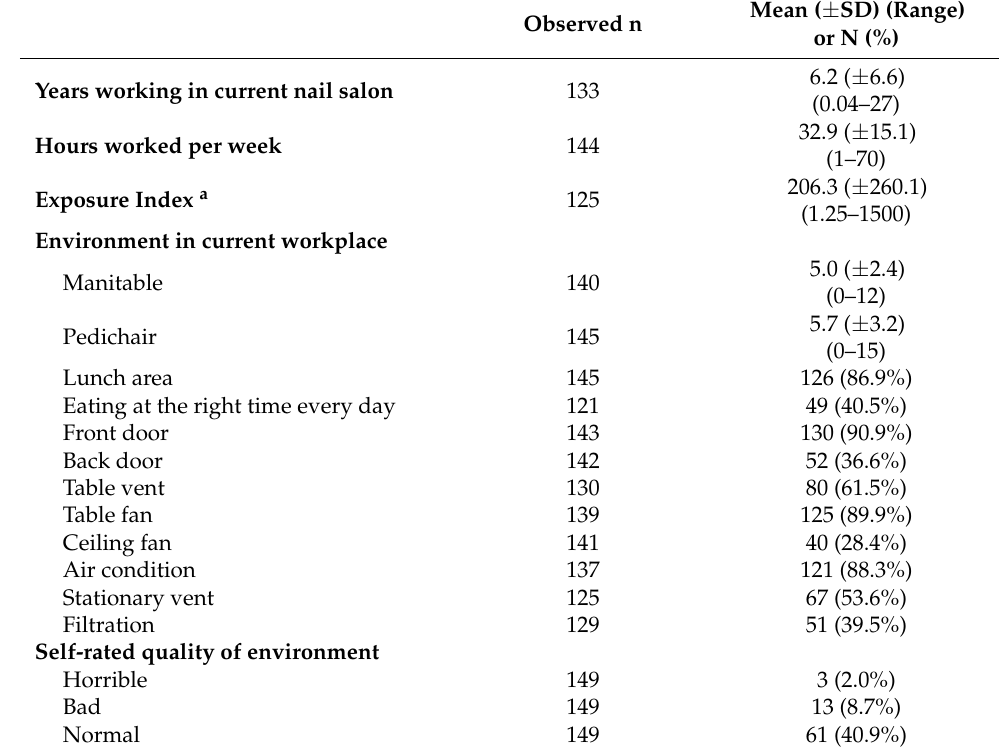
Table 2. Summary of toxin exposure among all nail salon workers ( n = 155). Raw means (standard deviations) and counts (proportions) are